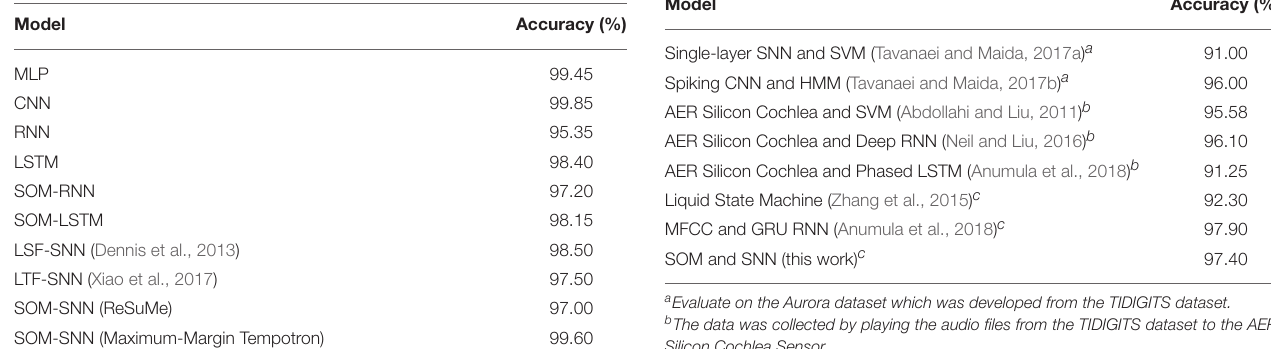
TABLE 1 | Comparison of the classification accuracy of the proposed SOM-SNN framework against other ANNs and SNN-based frameworks on the RWCP dataset.